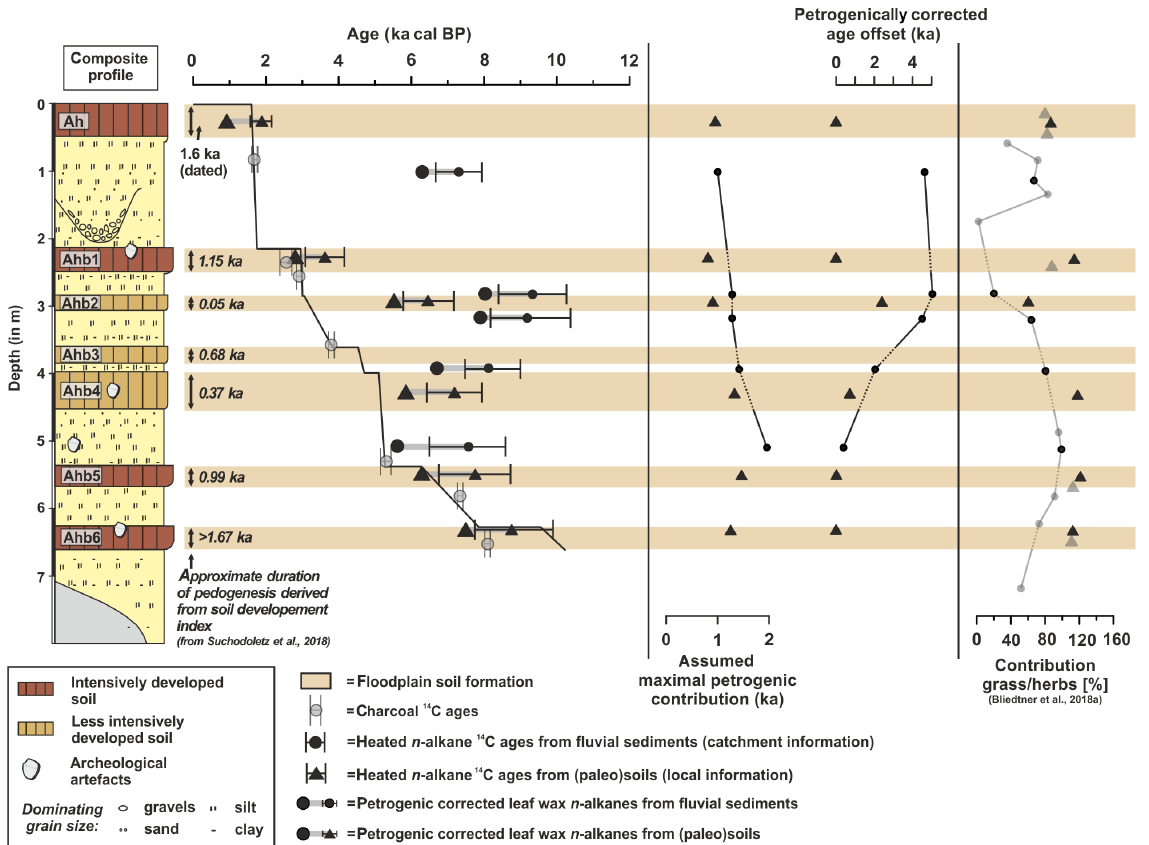
Figure 7. Chronostratigraphy of the investigated FSPS with leaf wax n -alkane 14 C ages corrected for maximal possible petrogenic contri- butions from catchment-derived Jurassic black clay shales. Contributions of grasses and herbs have been previously reported by Bliedtner et al. (2018a). Data points showing the percentages of grasses and herbs derived from Bliedtner et al. (2018a) that do not have direct 14 C age information from this study are plotted in a transparent way, and data points with such 14 C age information are shown without